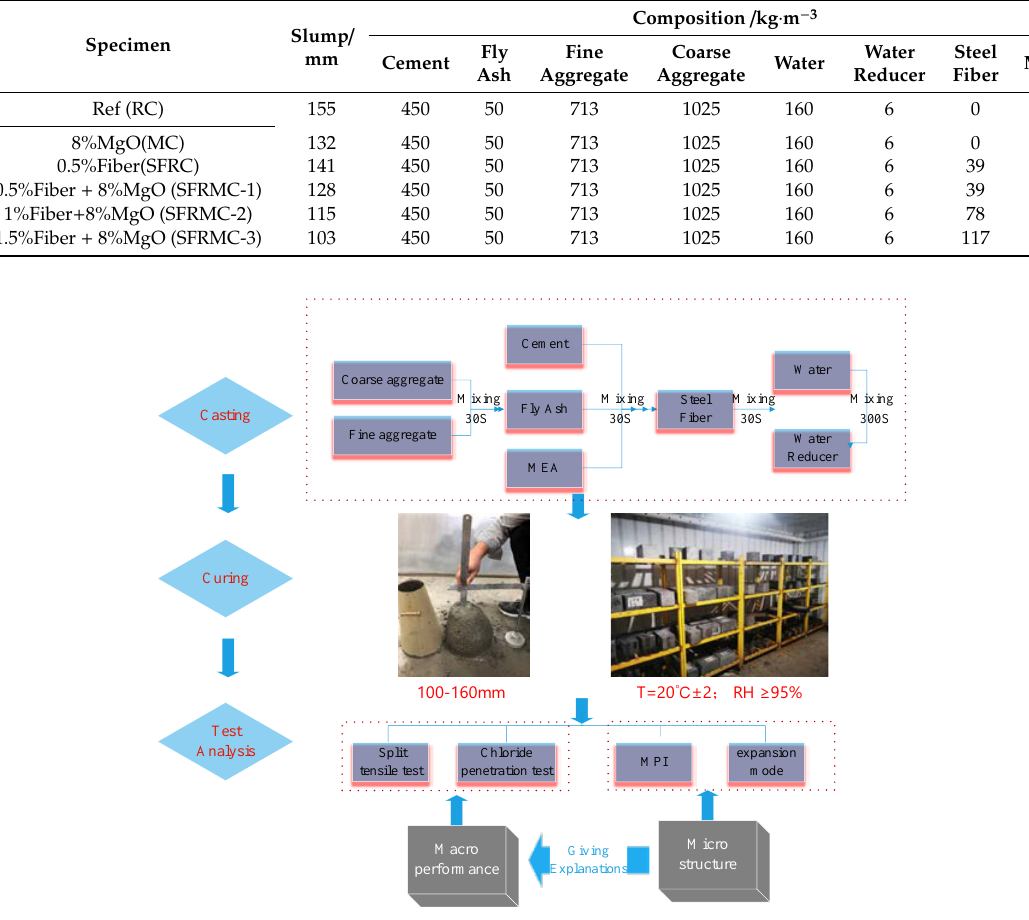
Table 2. Mix proportion of concrete.